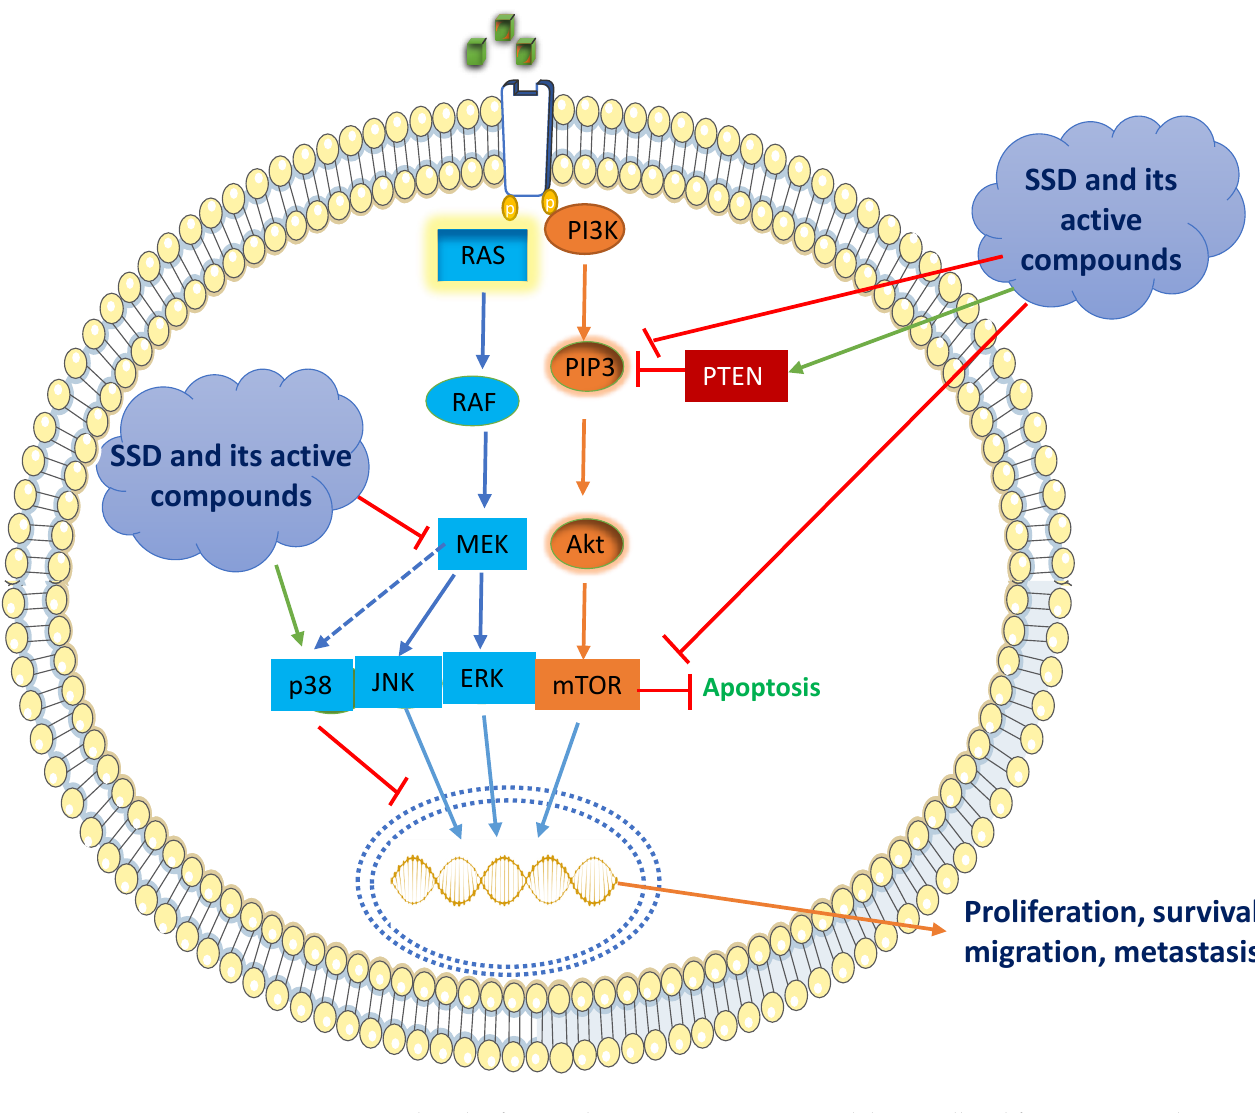
Figure 3. The role of SSD and its active constituents in inhibiting cell proliferation, survival, migration, and metastasis through the RAS/Raf/MAPK and PI3K/Akt/mTOR signaling